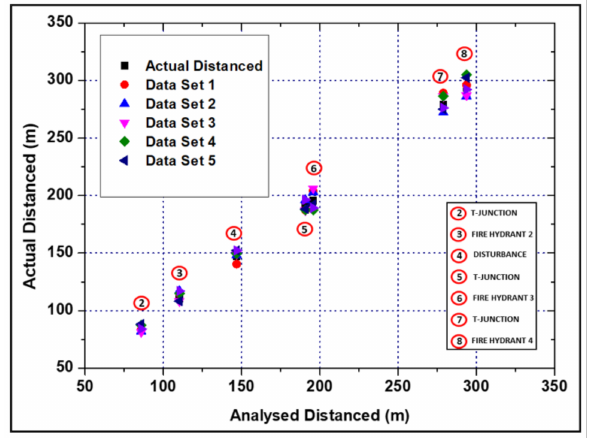
Figure 27. Scatter plot on repetition for 5 mm leak induced on fire hydrant 2 pipeline system analysis.